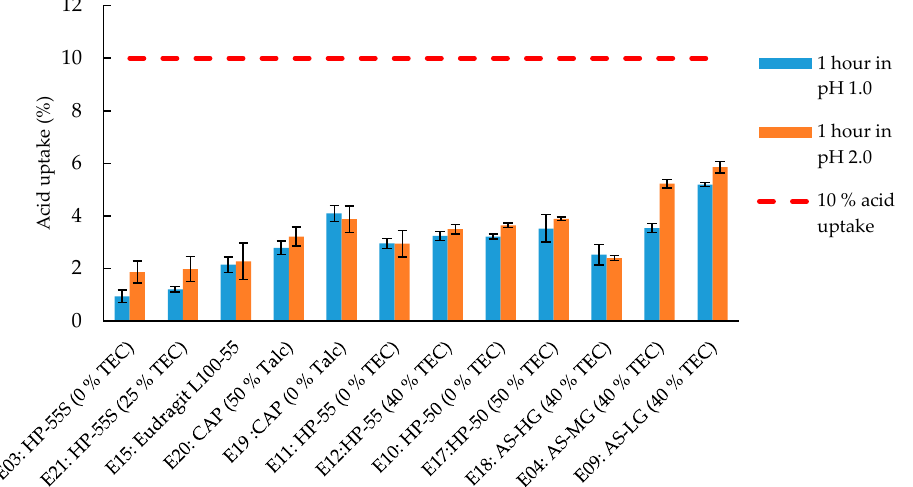
Figure 3. Acid uptake of enteric coated HPMC capsules following incubation in 0.1 N HCl or 0.01 N HCl. Horizontal line represents 10% acid uptake. Given are average acid uptake (%) ± SD; n = 6. % TEC and % talc are based on dry polymer weight.